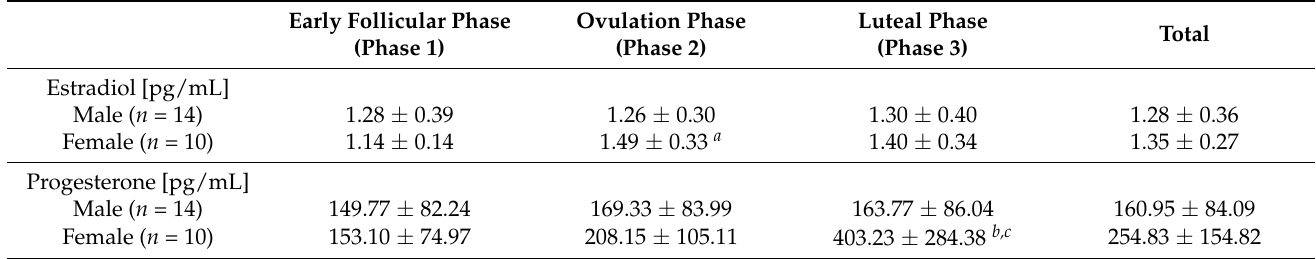
Table 1. Changes in estradiol and progesterone concentrations during the menstrual cycle.